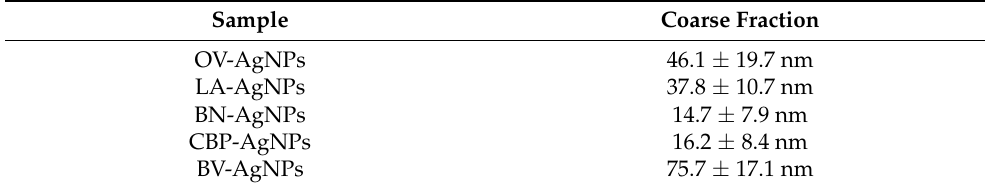
Table 5. Average diameter of AgNPs in samples with different plant extracts determined from TEM.